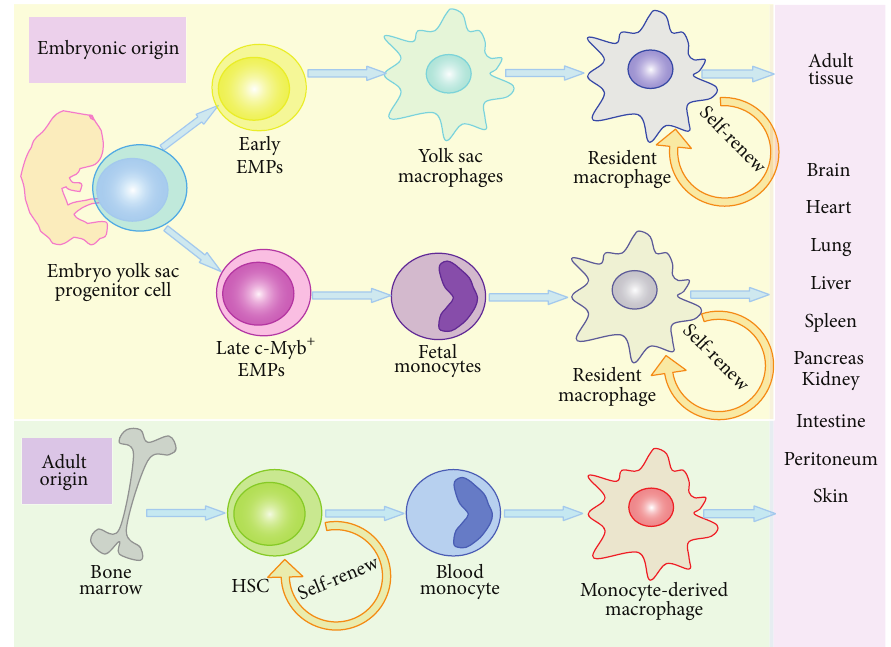
Figure 1: Origin and self-renewal of macrophage. Tissue macrophages have dual origins. One part develops from embryonic progenitors in the yolk sac and fetal liver and self-renew. The other part derives from hematopoietic stem cells (HSCs) in bone marrow and blood monocyte intermediates.HSCsalsocanself-replenishthemselves.Monocyte-derivedmacrophagescangiverisetosomesubsetsofresidentmacrophages under certain conditions. Resident macrophages and monocyte-derived macrophages ultimately constitute macrophages in all tissues, such as microglia in the brain, Langerhans cells in the skin, and Kupffer cells in the liver. EMPs, erythromyeloid progenitors; HSCs, hematopoietic stem